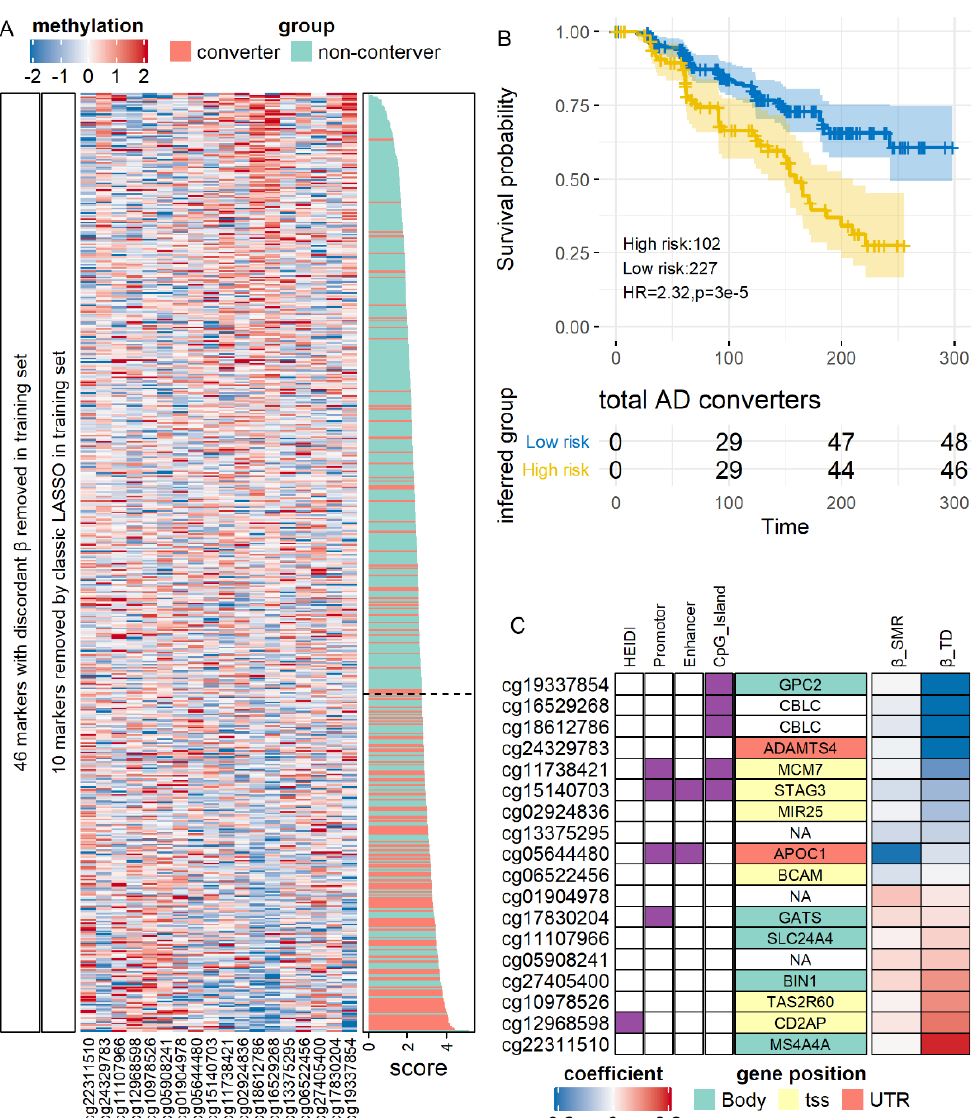
Figure 5. Validation of methylation predictive markers of AD. ( A ) Expression of markers after filtration and model construction in the training set. ( B ) Survival curve for conversion-to-AD in the test set. Time was shown in days. ( C ) Characteristics of the markers. HR: Hazard Ratio.